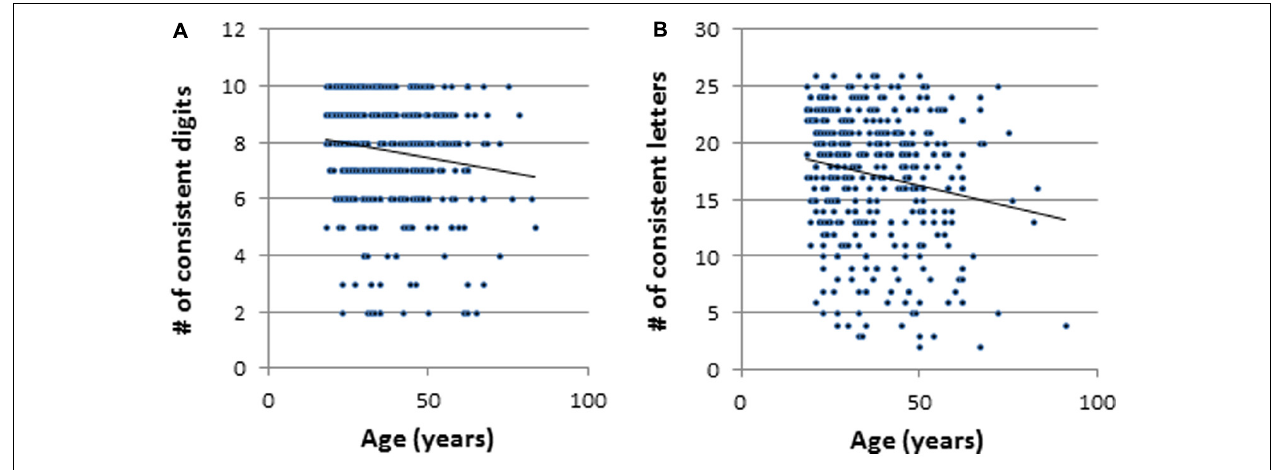
FIGURE 2 | Scatterplots of the relationship between age and the number of consistent color experiences: (A) digits, (B) letters. * p < 0.05, # = number.